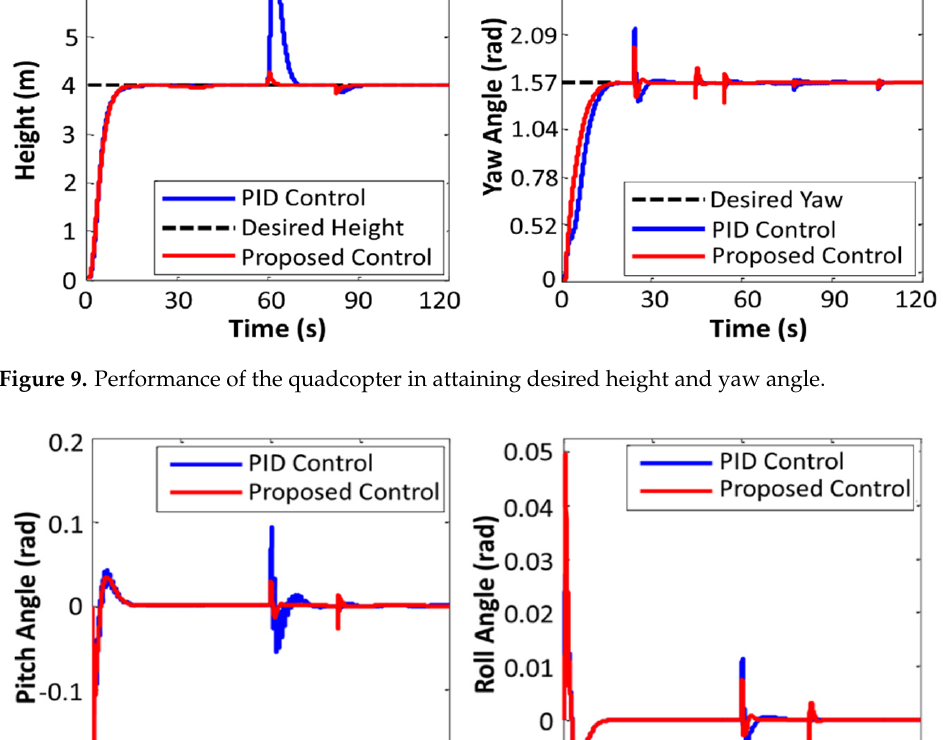
, 𝑢 , 𝑢 and 𝑢 are plotted in (cid:2869) (cid:2870) (cid:2871) (cid:2872)